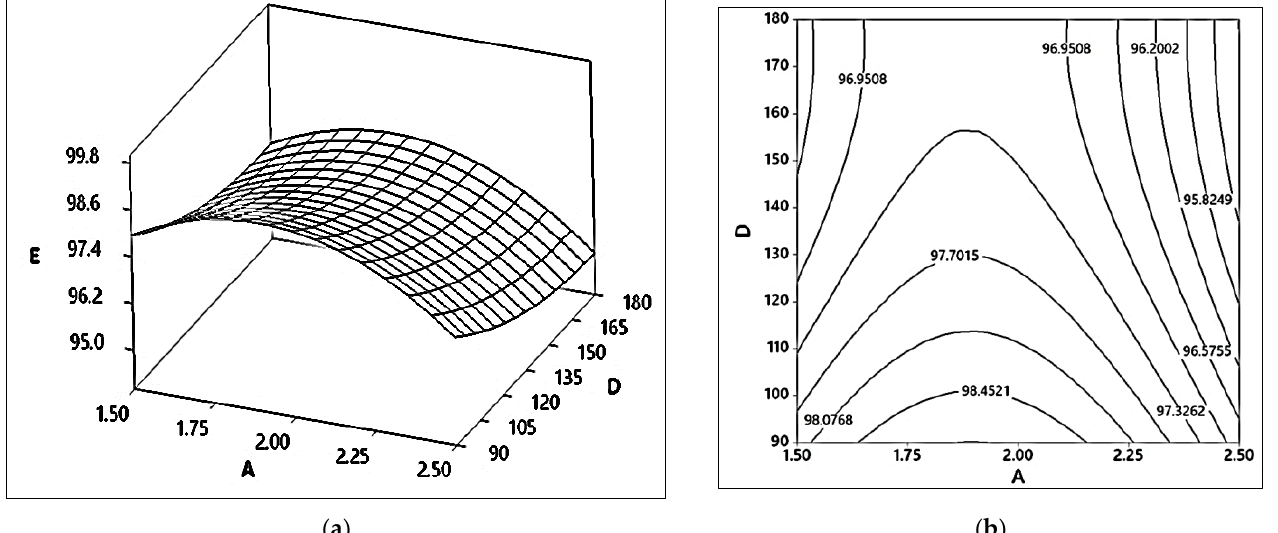
Figure 6. Interaction effect of the methanol to oil molar ratio and reaction temperature on the acidity removal of the WCO esterification process. ( a ) A 3D response surface plot of E (%) vs. A (wt.%) and D (minutes). ( b ) A 2D contour plot between A (wt.%) and D (minutes).